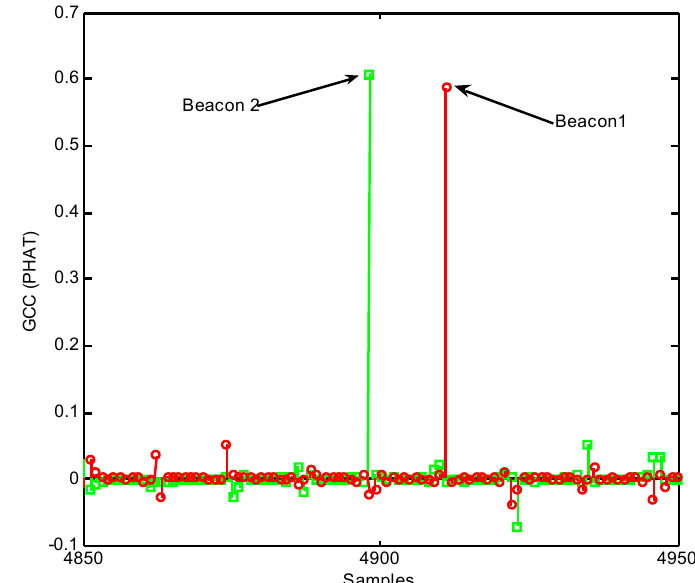
Figure 7. Beacon detection in the absence of noise, by applying generalised cross-correlation (GCC) with PHAT